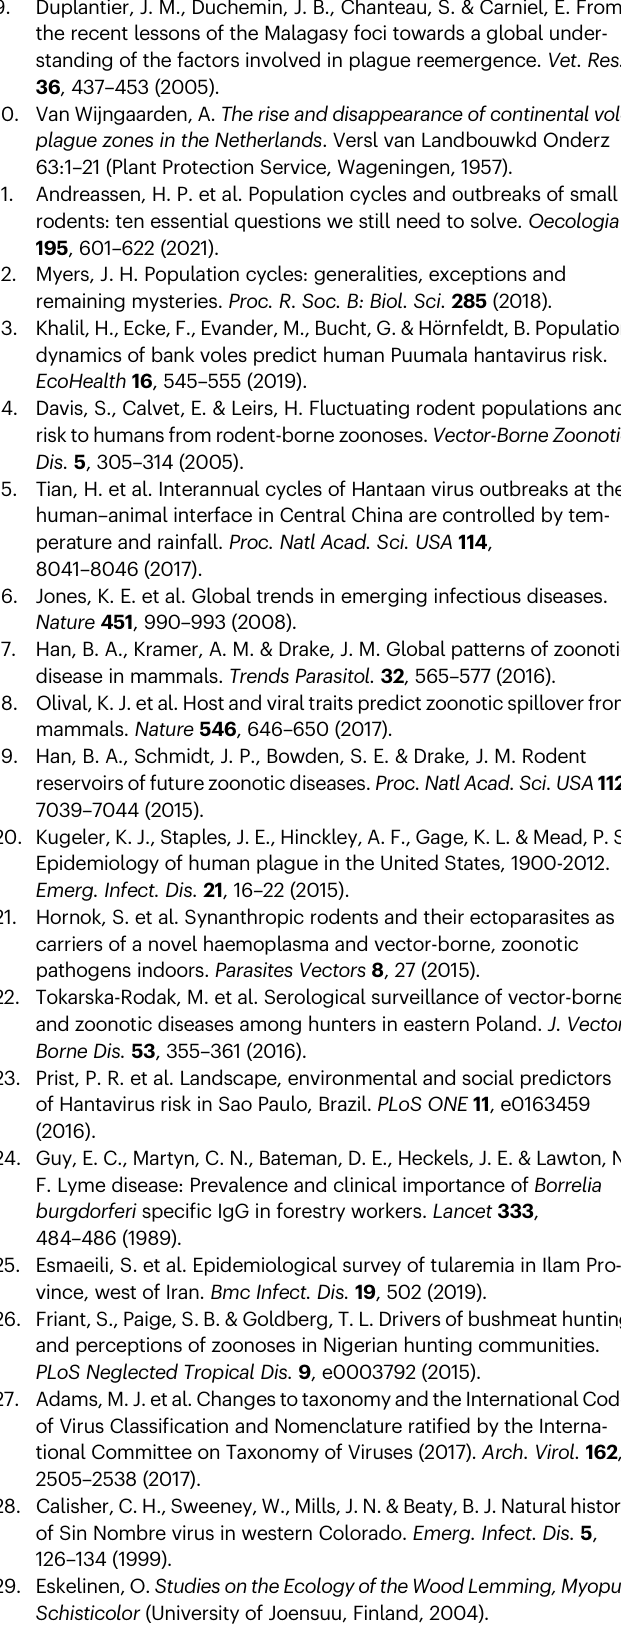
(Table 1) and synanthropic status (Table 3). Candidate predictors